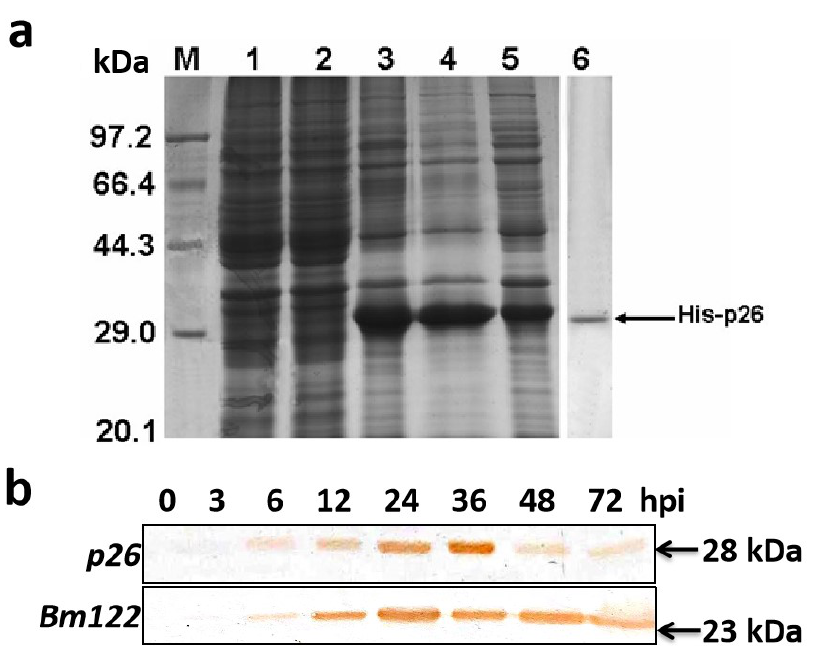
Figure 2. Overexpression of p26 in E. coli and Western blot analysis of p26 in BmNPV-infected BmN cells. ( a ) SDS-PAGE and Western blot analysis of the fusion protein His-p26 expressed in E. coli BL21 cells. M, protein molecular weight markers; Lane 1, BL21 cell proteins; Lane 2, proteins from BL21 cells transformed with pET-28a plasmid; Lane 3, proteins from BL21 cells transformed with pET-28a-p26; Lane 4, proteins in the sediment of supersonically broken BL21 cells transformed with pET-28a-p26; Lane 5, proteins in the supernatant of supersonically broken BL21 cells transformed with pET-28a-p26; Lane 6, Western blot analysis of the expressed His-p26 protein using an anti-His monoclonal antibody. ( b ) BmN cells were infected with wild-type BmNPV (MOI = 10.0), and protein samples were then harvested at 0, 3, 6, 12, 24, 36, 48, and 72 hpi, separated via 10% SDS-PAGE, transferred onto PVDF membranes, reacted with an anti- p26 polyclonal antibody or an anti- Bm122 polyclonal antibody, and detected with a DAB substrate. The immunoreactive bands are indicated by arrows, and the size is indicated on the right.